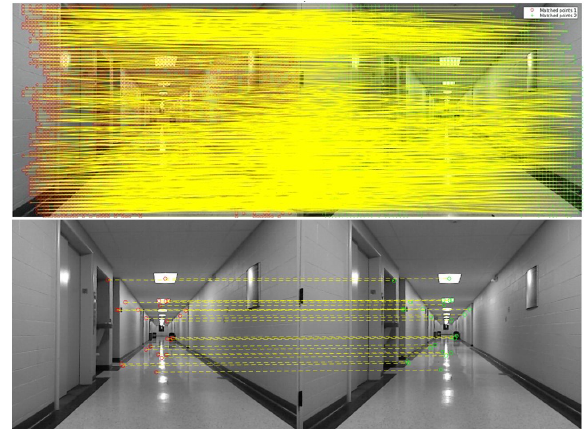
Figure 8. RANSAC feature matching inliers with CNN features (top) and SURF (bottom) on Group 1 testing data.